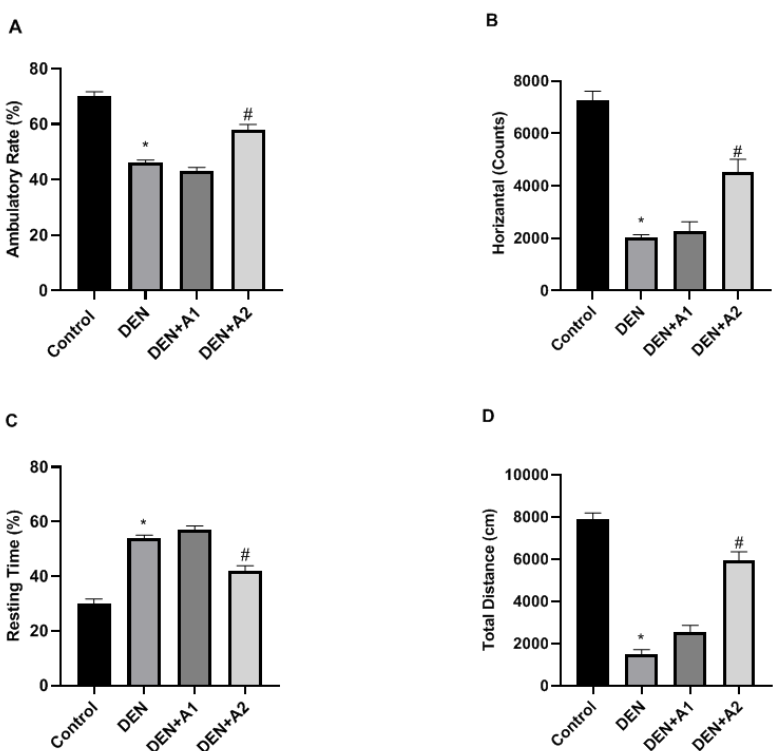
Figure 1. The effects of artichoke on ( A ) Ambulatory rates (%), ( B ) Horizontal activities (Counts), ( C ) Resting time (%), and ( D ) Total distance (cm) in DEN-intoxicated mice ( n = 8). Data are presented as means ± SD, * p < 0.05, # p < 0.05 vs. DEN group; DEN: diethylnitrosamine, A1: 0.8 g/kg Artichoke, A2: 1.6 g/kg artichoke.